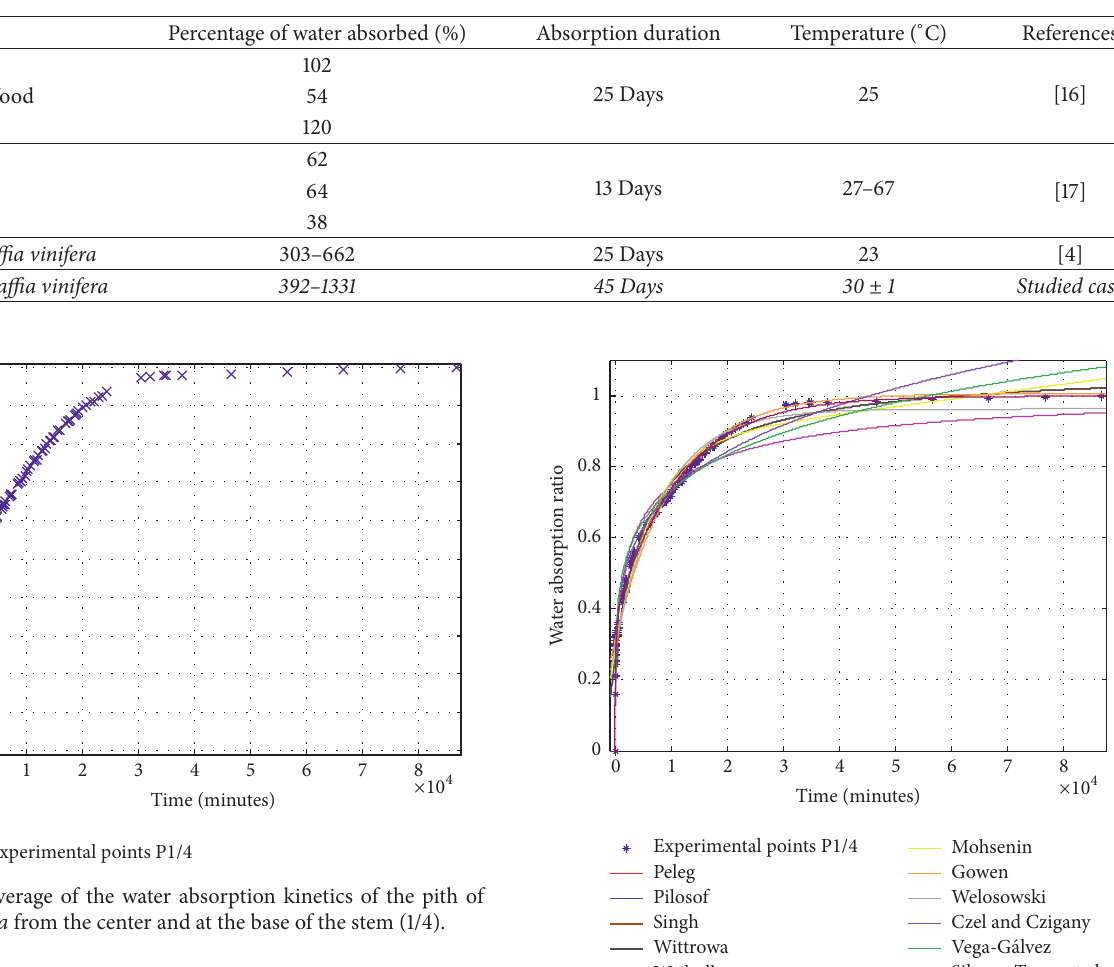
Table 2: Comparison of the percentage of water absorption of the pith of Raffia vinifera with other natural materials.